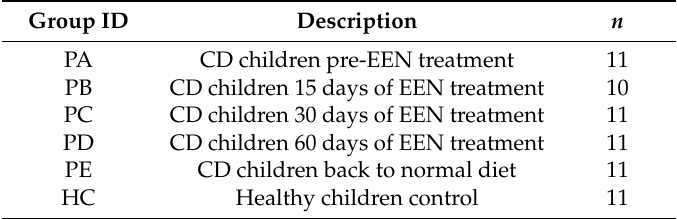
Table 6. Samples numbers and groups of paediatric Crohn’s disease before, during, and after EEN and healthy